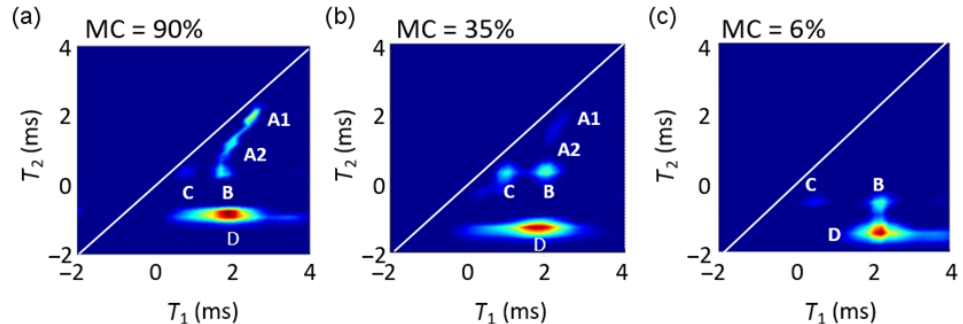
Figure 2. Two-dimensional T 1 – T 2 correlation spectra of the beech branchwood sample at: ( a ) MC = 90%, ( b ) MC = 35% and ( c ) MC = 6%. The five peaks are attributed to free water in cell lumina (A1 and A2), protons of bound water (B and C) and solid wood protons (D) as discussed in the text.